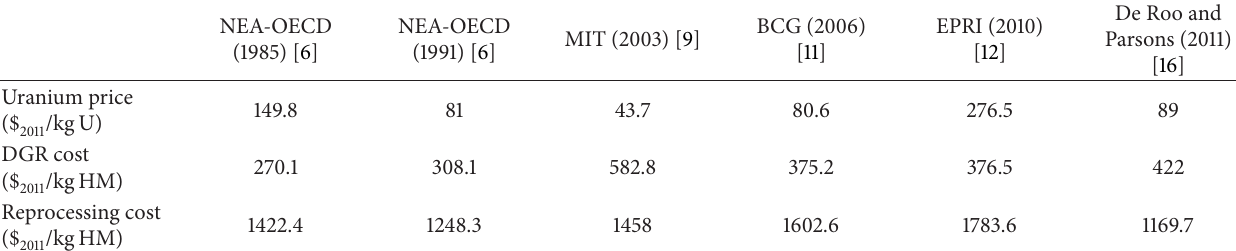
Table 2: Results obtained from studies updated to